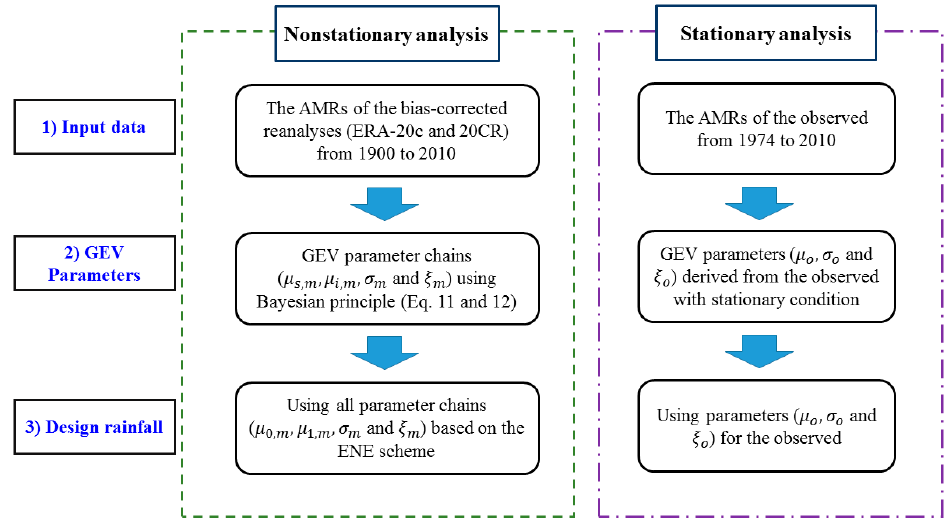
Figure 2. A flow chart for estimating design rainfall with the nonstationary condition and stationary condition (see Supplementary Material for the detailed equations).